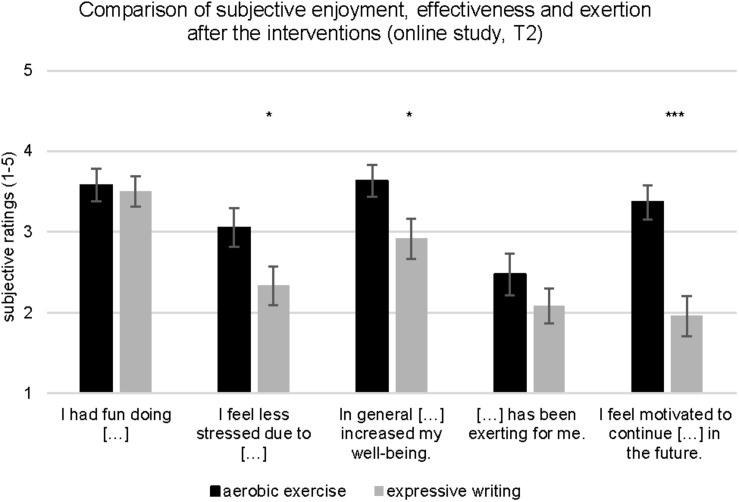
Participants’ ratings of enjoyment, subjective effectiveness of the intervention and exertion (online pilot study: aerobic exercise group, expressive writing group). Vertical bars denote ± standard errors. Significant differences between groups are indicated (*p ≤ 0.05; **p ≤ 0.01; ***p ≤ 0.001).